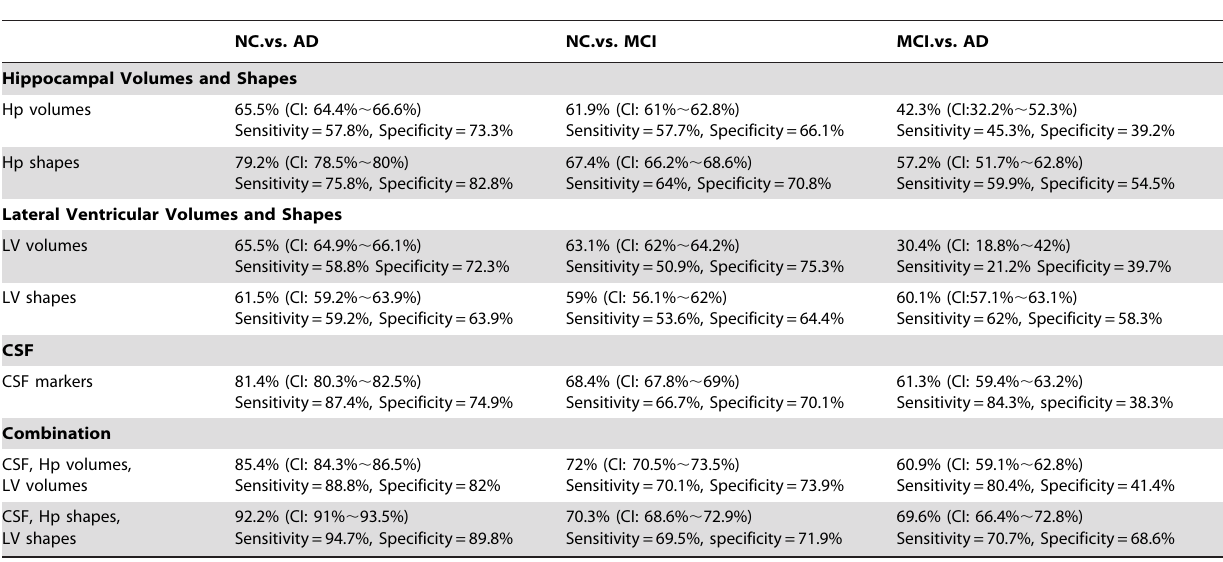
Table 2. The classification accuracy, sensitivity, and specificity of the support vector machine (SVM) classifiers are given for distinguishing normal controls (NC) and subjects with Alzheimer’s disease (AD), NC and subjects with mild cognitive impairment (MCI), and subjects with MCI and